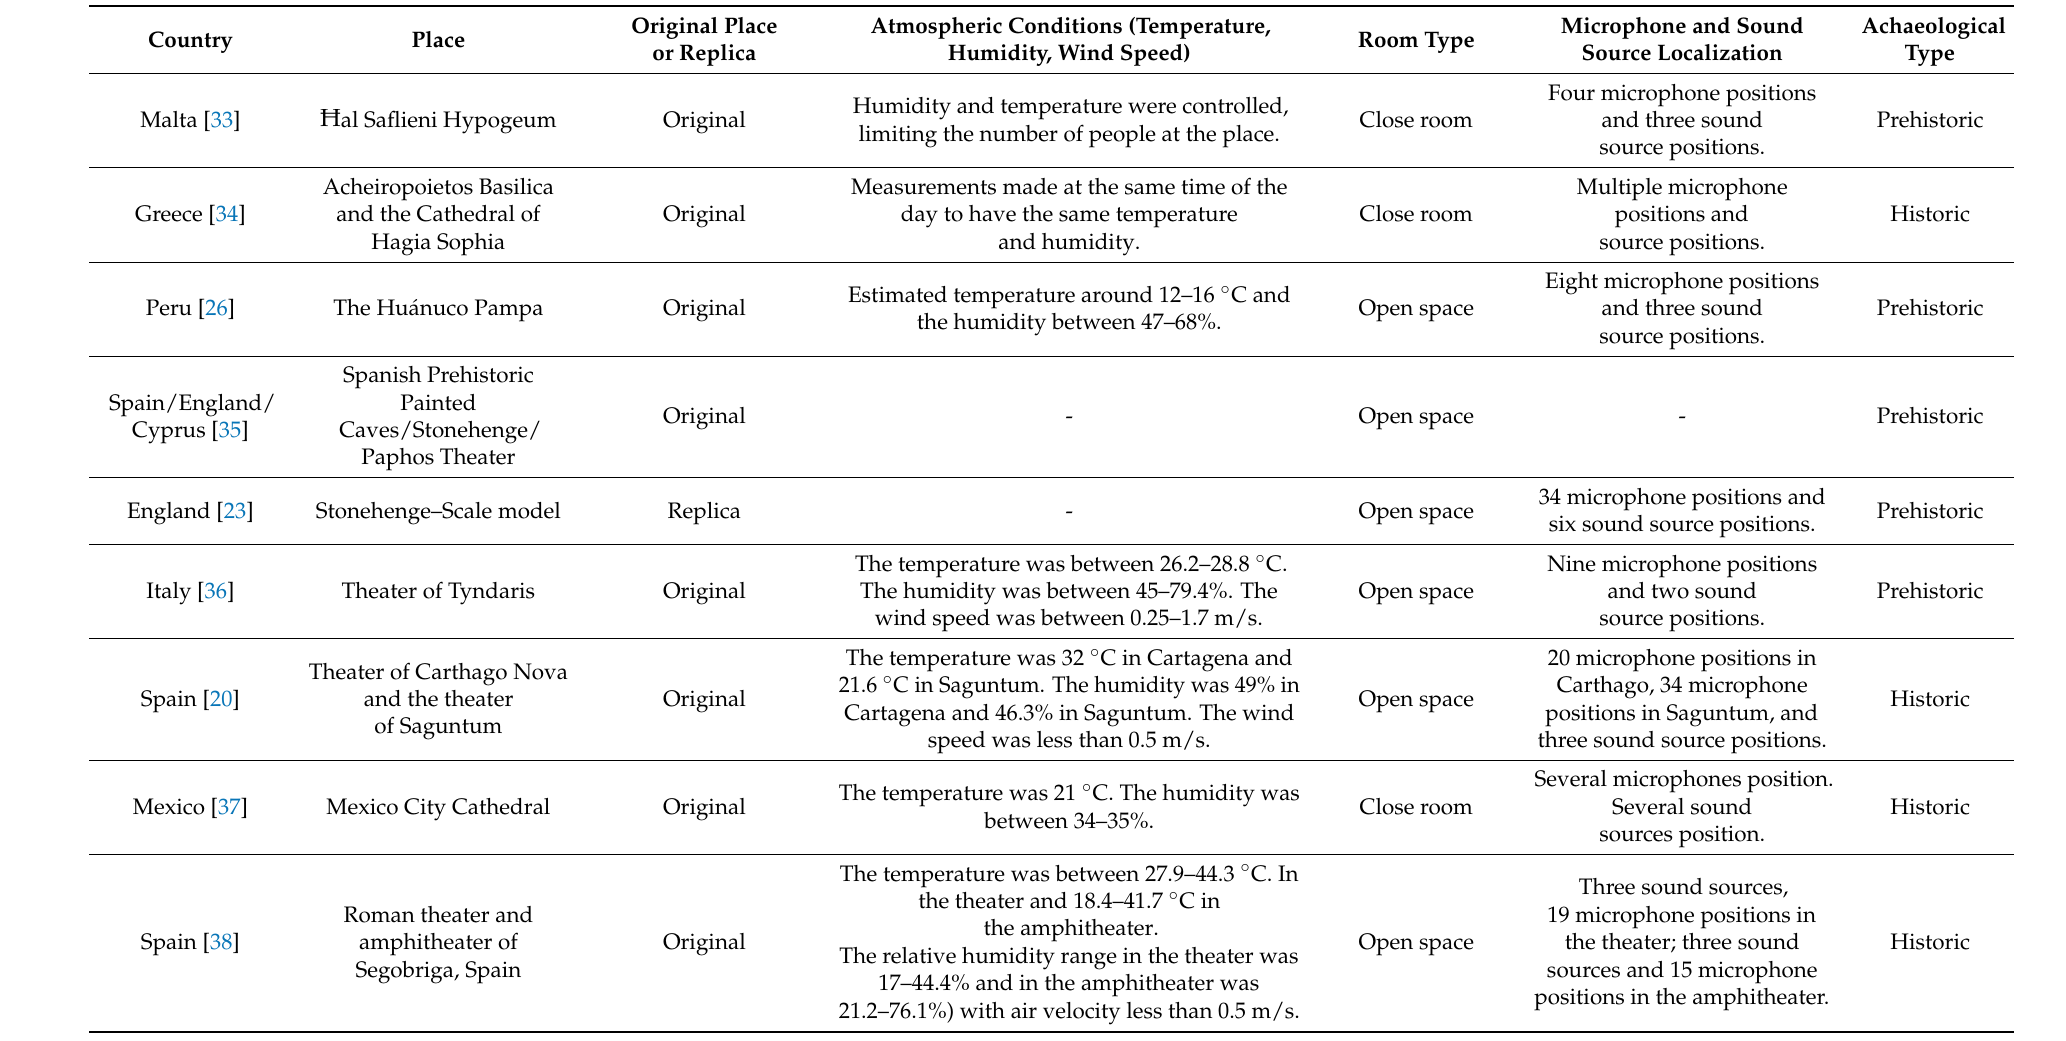
Table 1. Archaeoacoustics measurement and characterization of historical worldwide places.